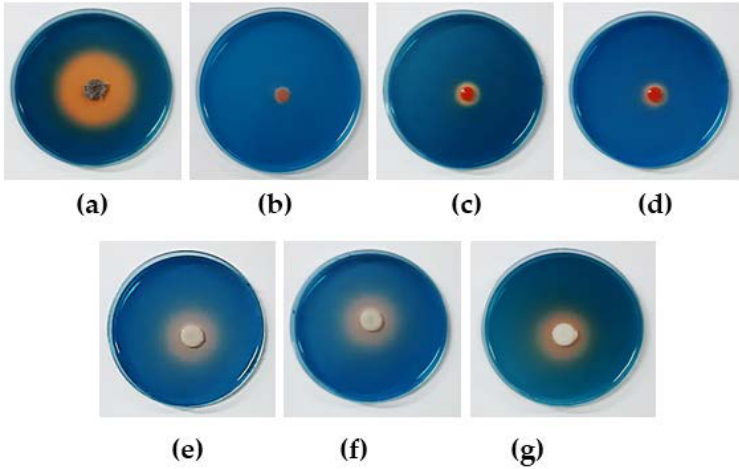
Figure 3. Siderophore production by antagonistic yeasts on chrome azurol S blue agar incubated for 10 days; ( a ) Pseudozyma hubiensis YE-21; ( b ) Rhodotorula mucilaginosa YE-171; ( c ) Rhodotorula taiwanensis YE-9; ( d ) R. taiwanensis YE-213; ( e ) Wickerhamomyces anomalus DMKU-CP122; ( f ) W. anomalus DMKU-CP127; and ( g ) W. anomalus YE-42 .